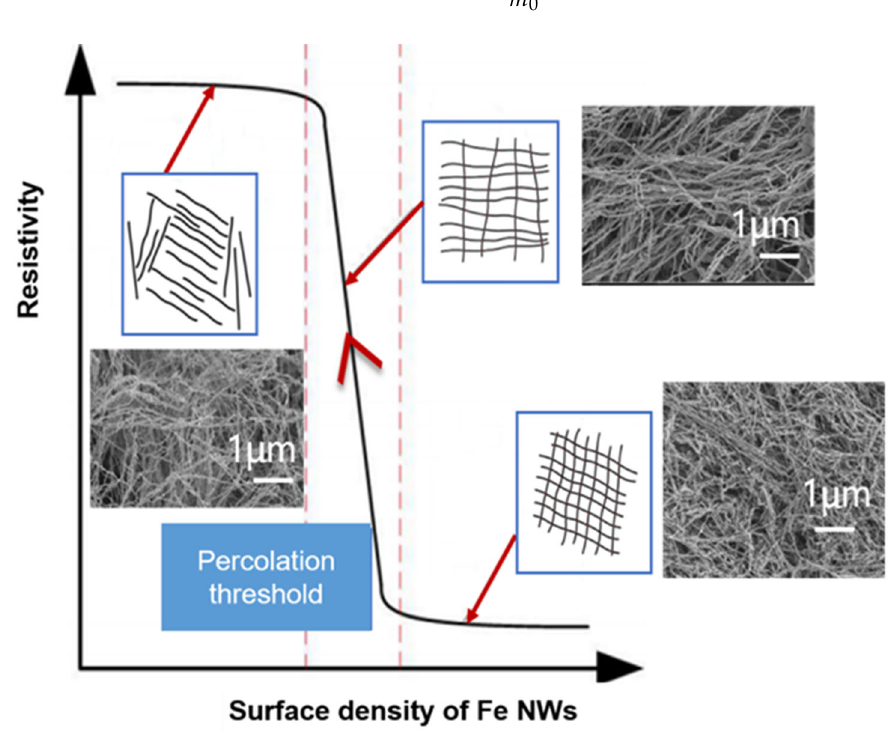
Figure 8. Percolation theory of flexible tensile strain sensors based on Fe NWs.